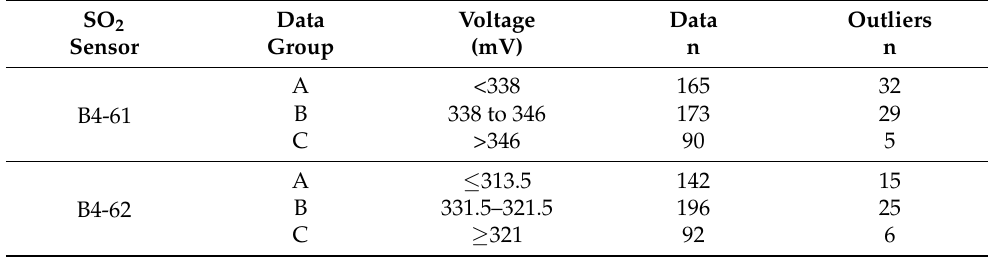
Table 3. Dataset from the training campaign disaggregated by voltage range.